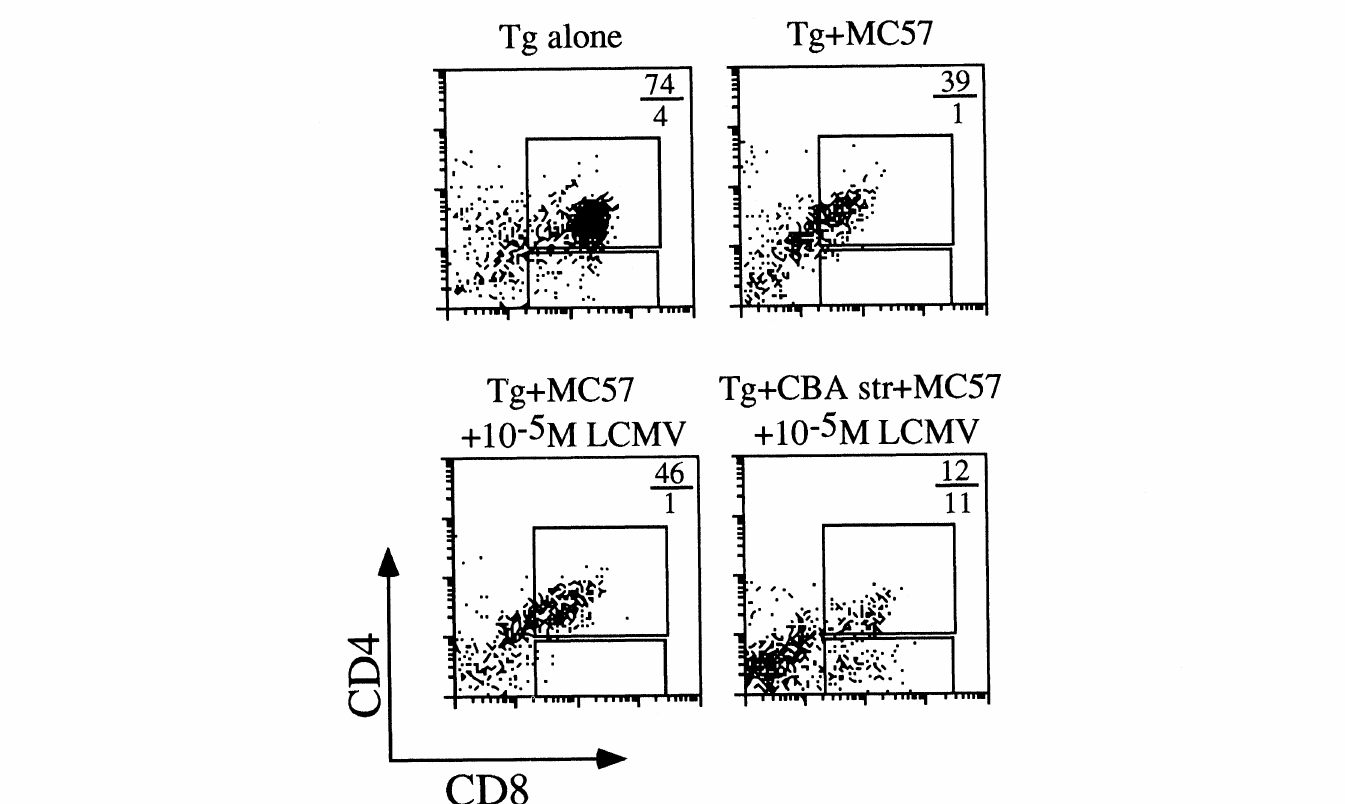
FIGURE 3 Positive selection can occur by multicellular signaling. E 17 transgenic cells when (A) cultured alone or in the presence of H-2 expressing fibroblasts (C) with or (B) without nominal peptide, do not differentiate into CD4-CD8 cells. However, when El7 transgenic cells are cocultured with H-2b-expressing fibroblasts and nonselecting (H-2 k) stroma in the presence of the nominal LCMV peptide, some induction of CD4-CD8 cells is